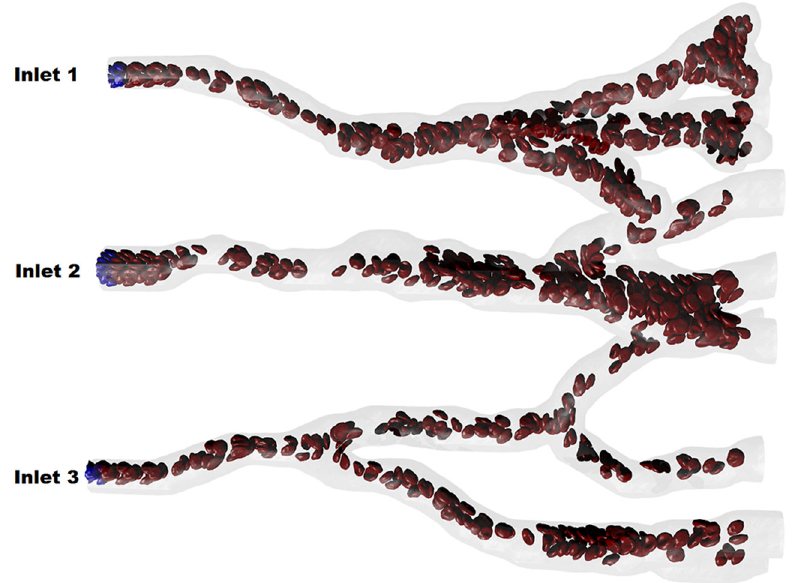
Fig 7. Snaphot for simulation of the blood flow in part of arterial network with three inlets and multiple outlets. The complex microvascular network was constructed using an angiogenesis model [49]. The walls of the microvascular network were formed by stationary DPD particles. An extra bounce-back reflection was applied to fluid particles to prevent them from entering the solid wall domain.